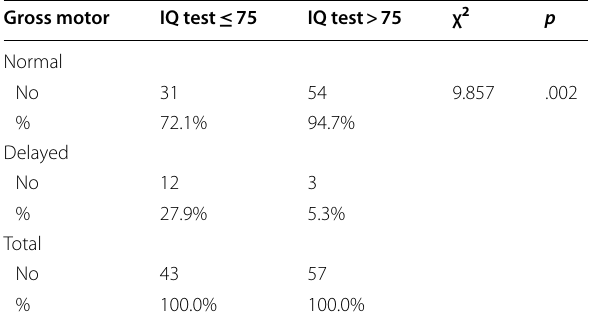
Table 3 The relation between IQ and gross motor